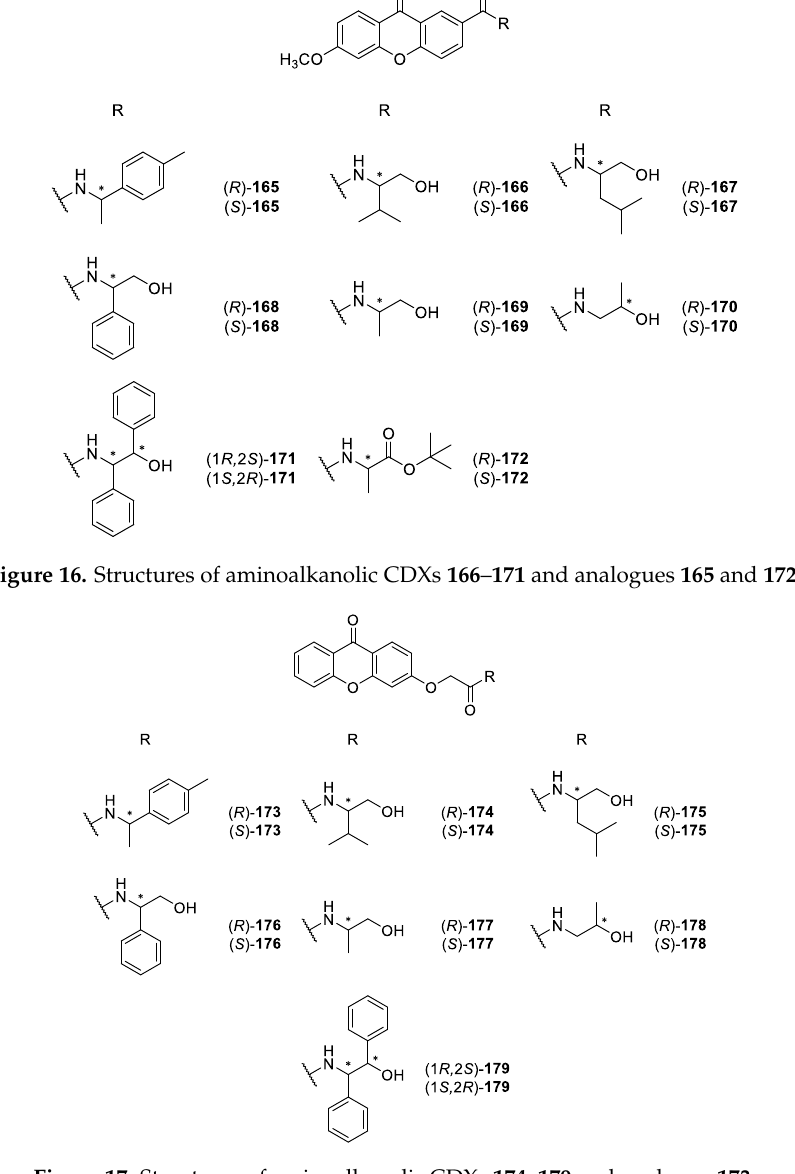
Figure 17. Structures of aminoalkanolic CDXs 174 – 179 and analogue 173 .